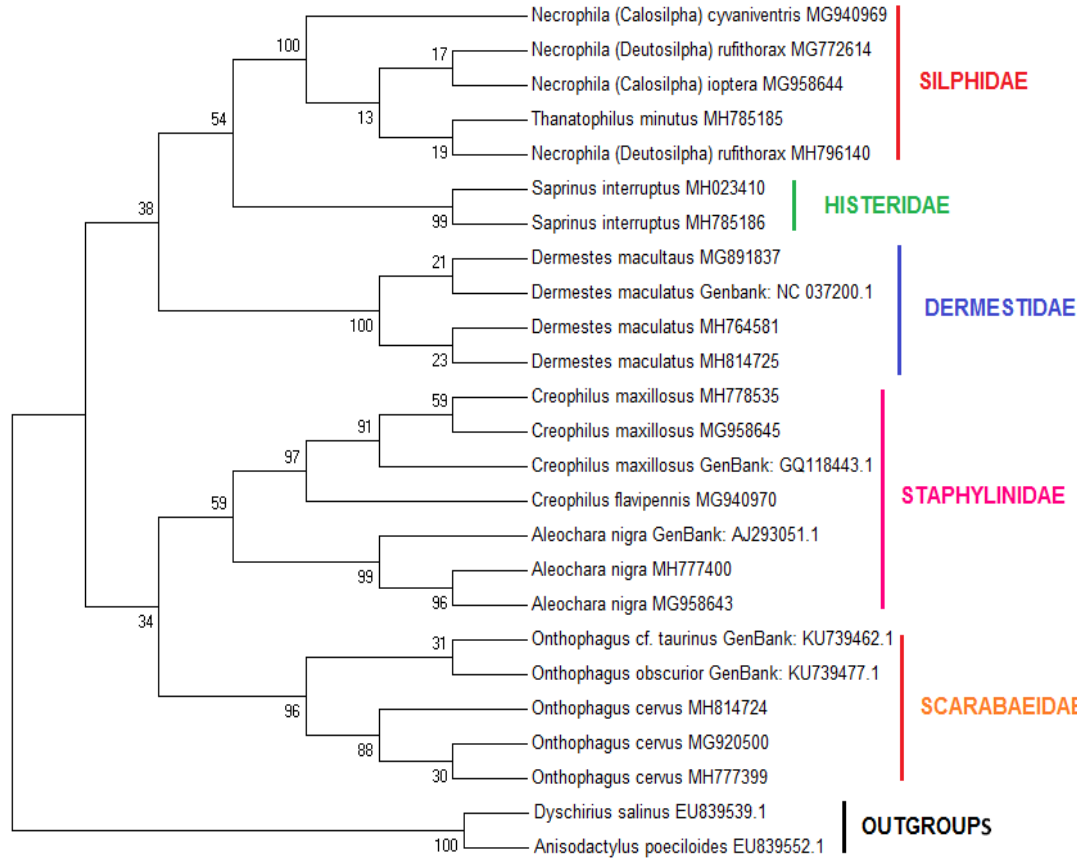
Figure 3. Neighbor joining (NJ) for beetle species of forensic interest in India inferred from COII gene sequence.